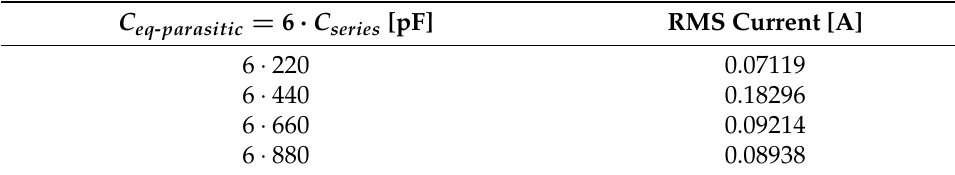
Figure 17. FFT of i cm with different values of C series . Table 3. RMS values of the i cm currents.